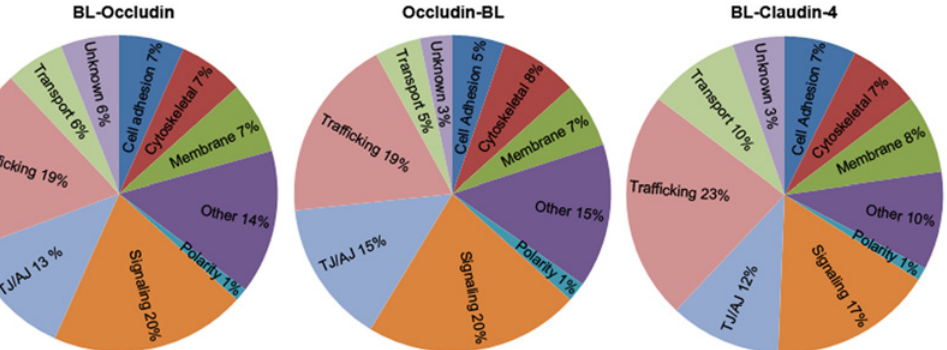
Fig 4. Functional analysis of top 150 enriched proteins recovered from cells expressing biotin ligase fusion proteins. Streptavidin-purified proteins identified by mass spectrometry from cells expressing biotin ligase fused to the N terminus of Ocln ( BL-Occludin , left ), the C terminus of Ocln ( Occludin-BL , middle) or the N terminus of Cldn4 ( BL-Claudin 4 , right ). Functional classification revealed similar distribution for the two Ocln constructs, although individual proteins within the functional groups trafficking-, signaling-, cell adhesion etc. vary, or are more or less abundant (higher or lower average normalized-PSM/ OPN). Functional groups of proteins recovered from cells expressing biotin ligase fused to the N terminus of Cldn4 shows similar functional distribution of enriched proteins as both of the Ocln fusion proteins, although there are slightly more trafficking proteins tagged by BL-Cldn4. Enriched = (cid:2) 3-fold increase compared to biotin ligase alone (as determined by the average normalized